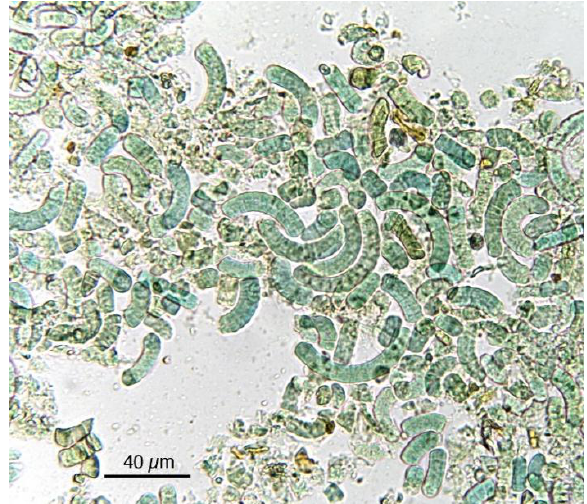
Figure 3. Most Spirulina cells, after their exsiccation and transformation into marketed products, are fragmented, but the original characteristics useful for identification are still evident.